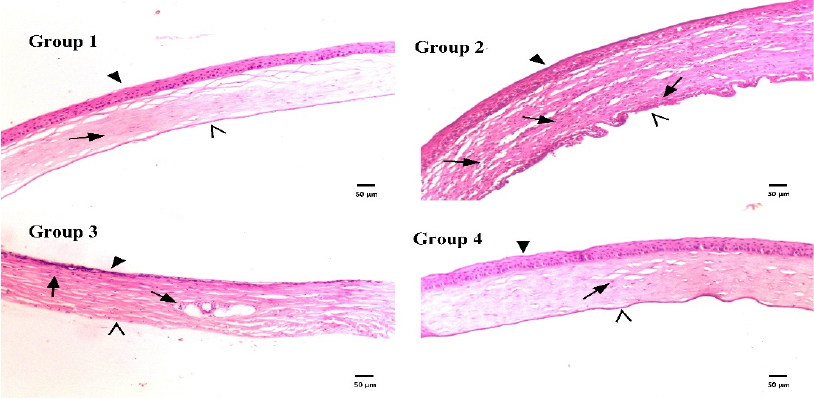
Figure 6. Histological structures of rat corneas stained with H&E of normal rat corneas (group 1), untreated rat corneas infected with MRSA (group 2), rat corneas infected with MRSA and treated with GTX aqueous dispersion (group 3) and rat corneas infected with MRSA and treated with GTX-loaded cubosomal dispersion (group 4).